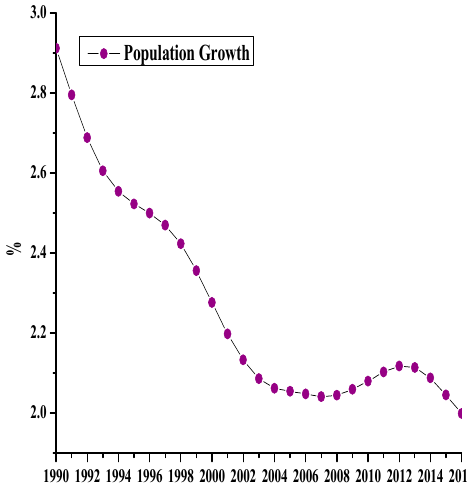
Figure 7. Population Growth in Pakistan.